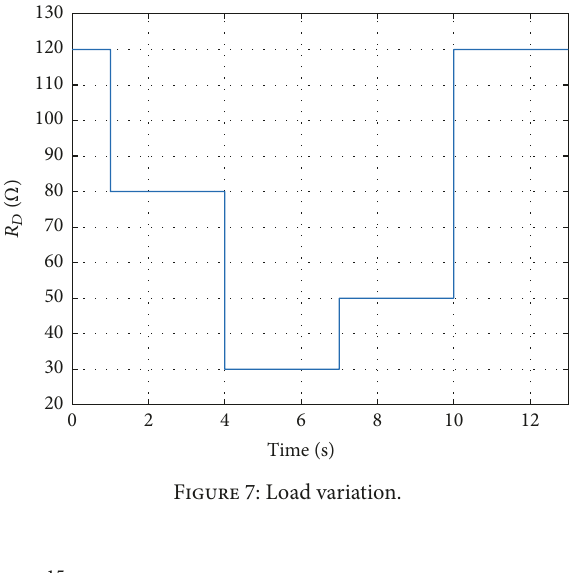
Figure 9: Generator 𝑑𝑞